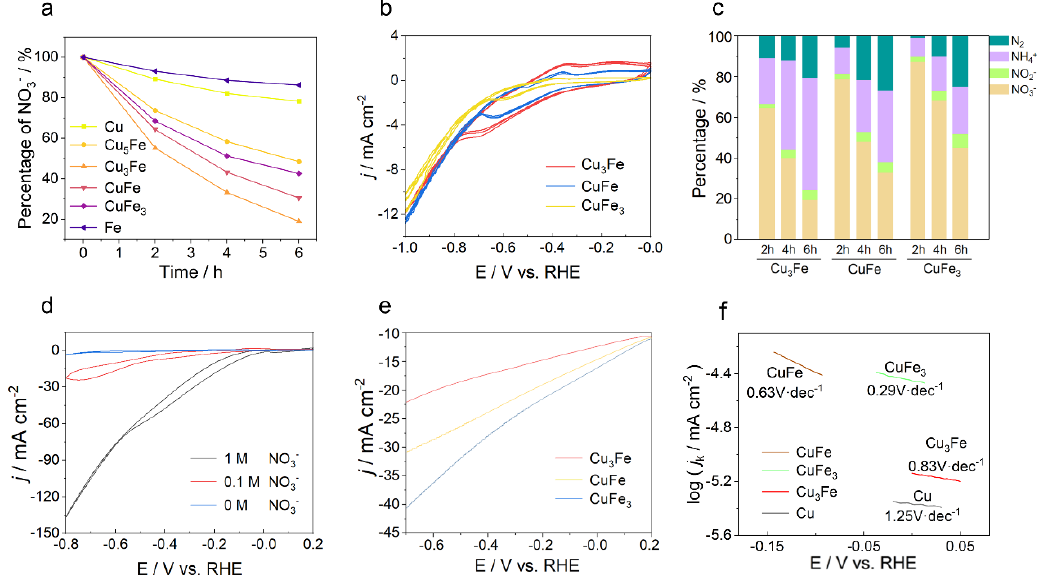
Figure 2. Electroreduction performance differences among catalysts. ( a ) The time-dependent con- centration of nitrate compared among different Cu-Fe ratio catalysts in electrolysis test. ( b ) CV plots in an electrolyte of 100 ppm NO 3 − -N and 0.1 M Na 2 SO 4 of different catalysts. ( c ) Time-dependent product distributions of different catalysts. ( d ) CV plots of Cu 3 Fe in electrolytes of different nitrate concentrations. Hydrogen evolution reaction (HER) performance. ( e ) LSV plots in 0.1 M NaOH